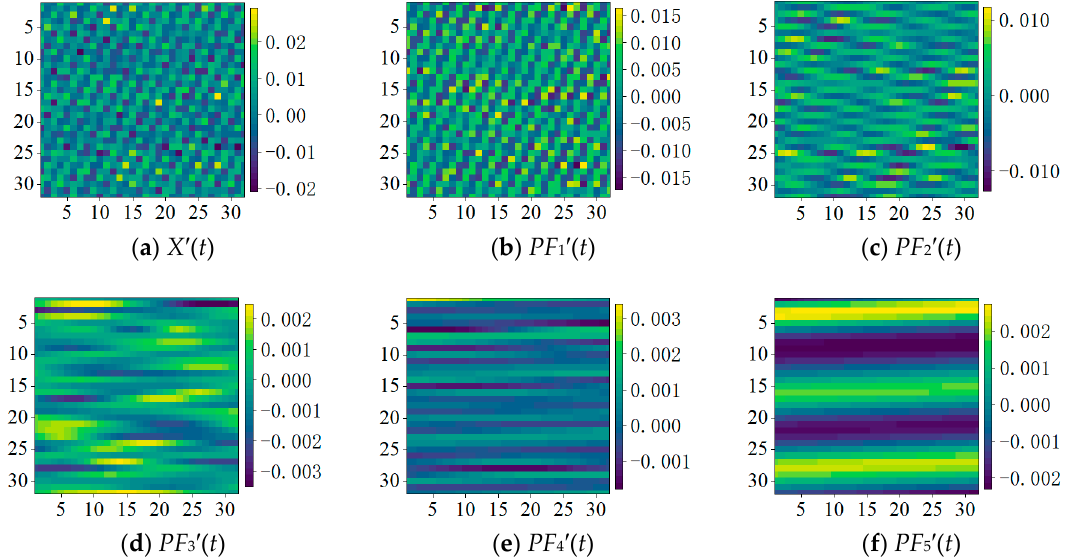
Figure 5. Two-dimensional vibration matrix visualization. ( a ) is the original vibration signal. ( b – f ) are the PF components.